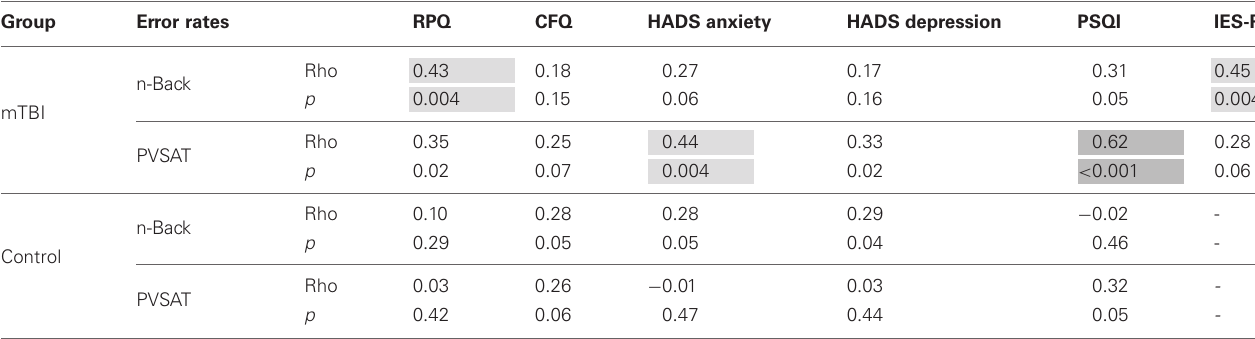
Table 2 | Correlations between symptom report and cognitive task performance. Group Error